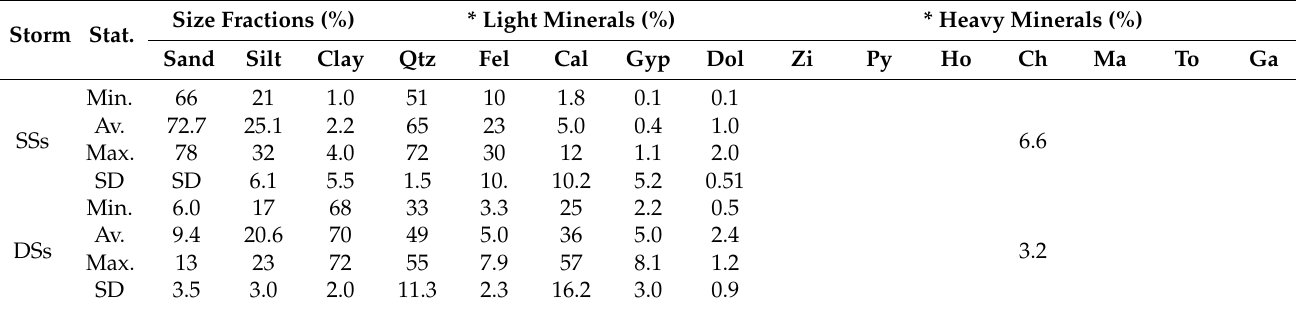
Figure 2. Grain size analyses of the SDSs in Iraq. Table 1. Size and mineralogical analyses of SDSs in Iraq [21].